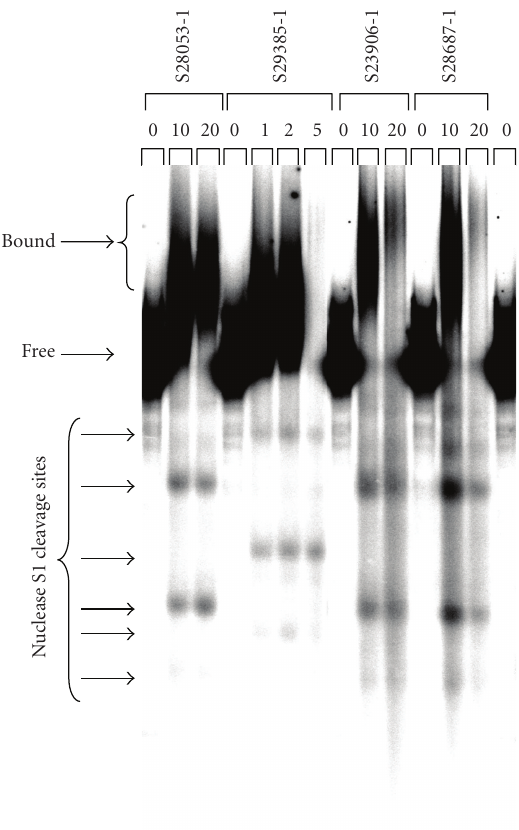
Figure 7: Nuclease S1 mapping of locally opened DNA structure. Increasing concentrations of the benzo-b-acronycine derivatives presented in Figure 5 were incubated with a radio-labelled 117- bp DNA fragment prior to subjection to nuclease S1 mapping of the induced locally single-stranded DNA portions generated upon DNA alkylation. DNA samples were separated on a 10% native polyacrylamide gel. Concentrations are expressed in μ M. The detailed experimental protocol is described in